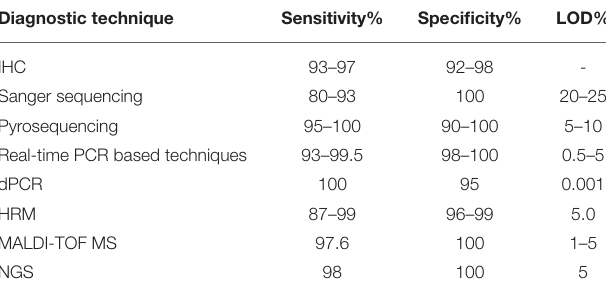
TABLE 1 | Sensitivity and specificity of the most commonly BRAF diagnostic